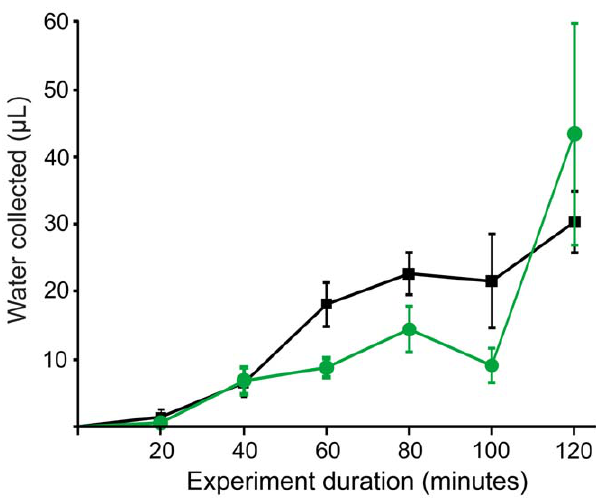
Figure 4. Water run-off dynamics of beetle and grass. Amount of water collected by beetles (black line, N=12) and grass (green line, N=12) exposed to fog in intervals from zero to 120 minutes with 20 minute increments (mean 6 SD). The water run-off in the beetles is a steady flow, in plants it is in cascades.